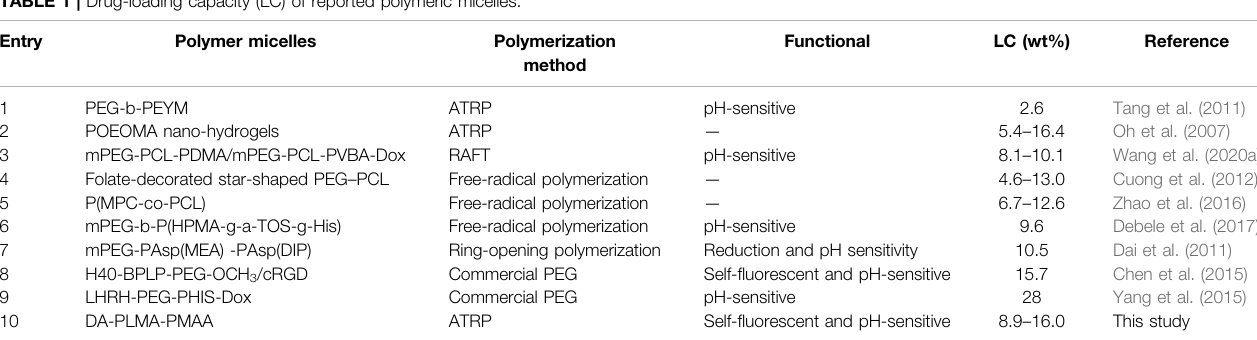
TABLE 1 | Drug-loading capacity (LC) of reported polymeric